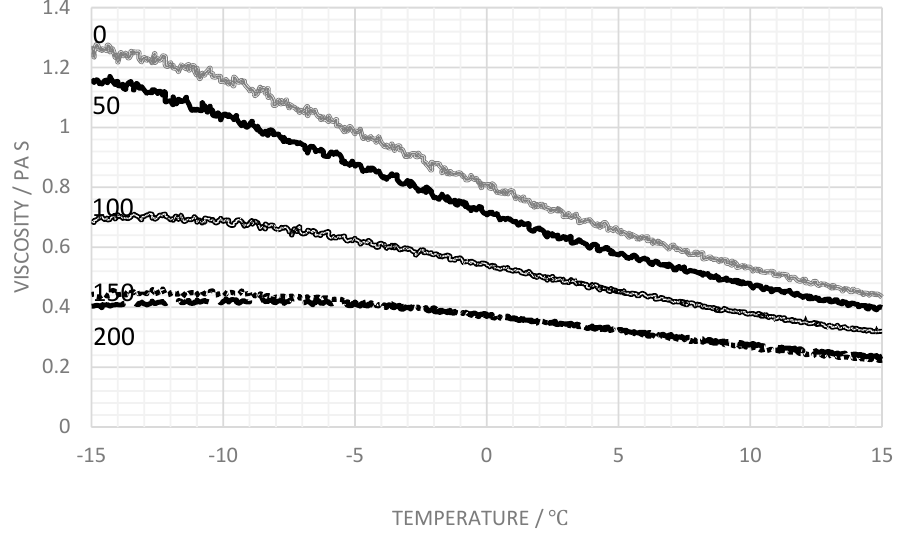
Figure 4. Viscosity variation for a 75 wt% dilution of Carbomer A with increasing Ca 2 + (mg L − 1 ), at a shear stress of 5 Pa.